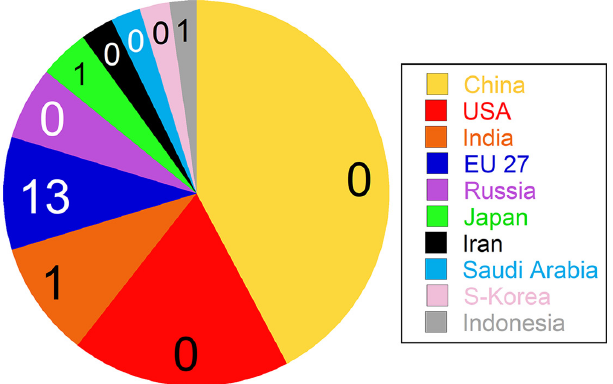
Fig. 14. – Pie chart of the 2020 CO 2 emission of the primary 10 emitters [39] and the number of United Nations COP conferences organised by the respective countries